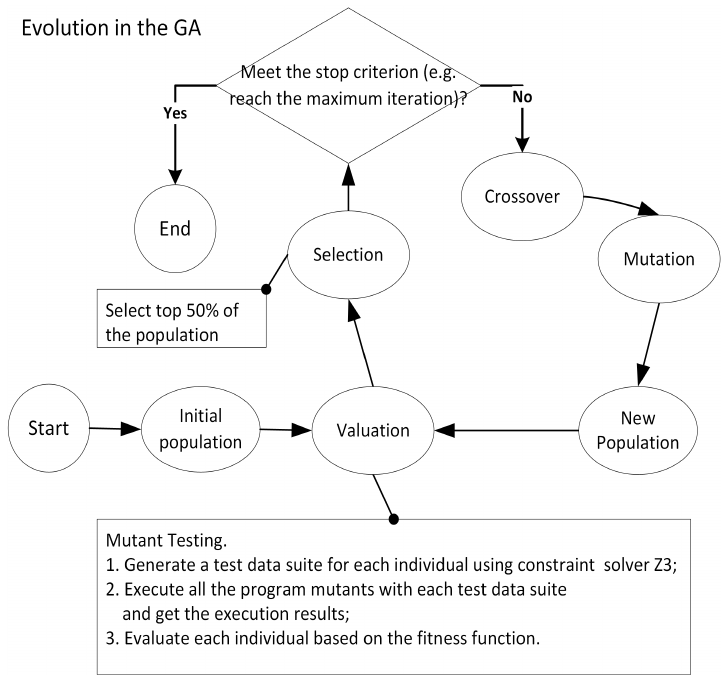
Figure 4. The evolution in